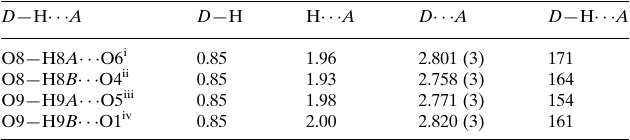
Hydrogen-bond geometry (A˚ , (cid:4)